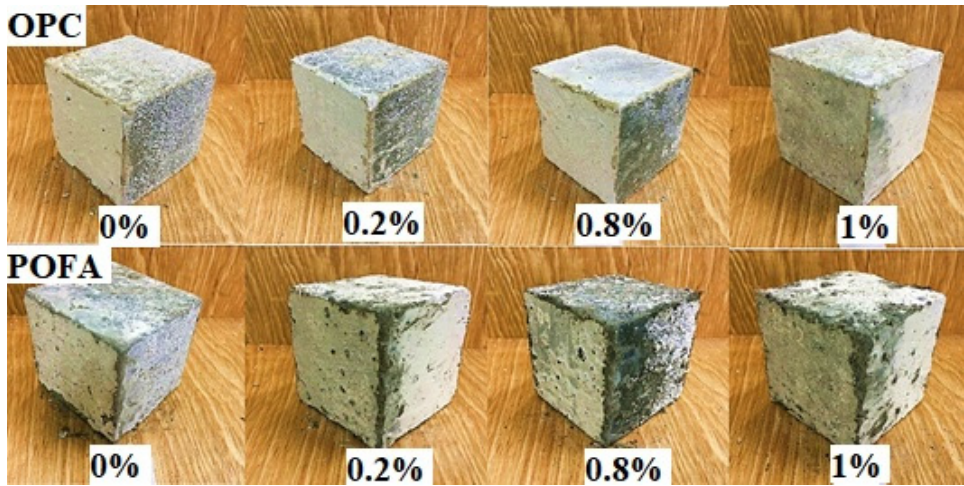
Figure 4. The appearance of concrete specimens exposed to a MgSO 4 solution for 12 months .